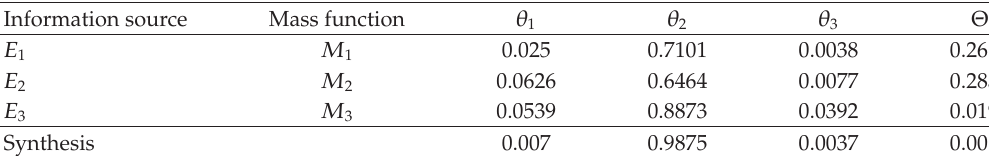
Table 5: Properties mass function synthesis